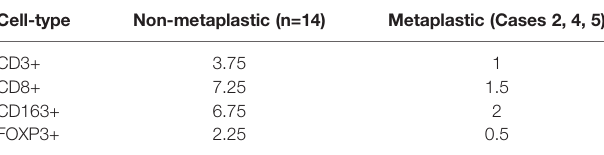
TABLE 5 | Variance in immune cells by mIF reported as median absolute